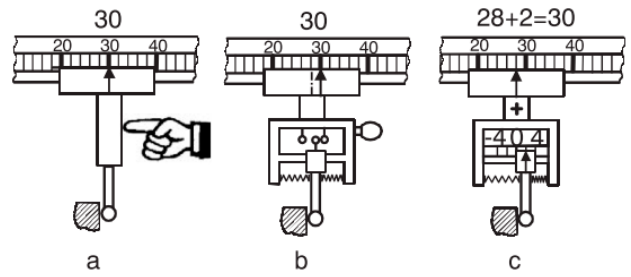
Figure 13. Hard ( a ), touch-trigger ( b ) and measuring ( c ) probe [119].